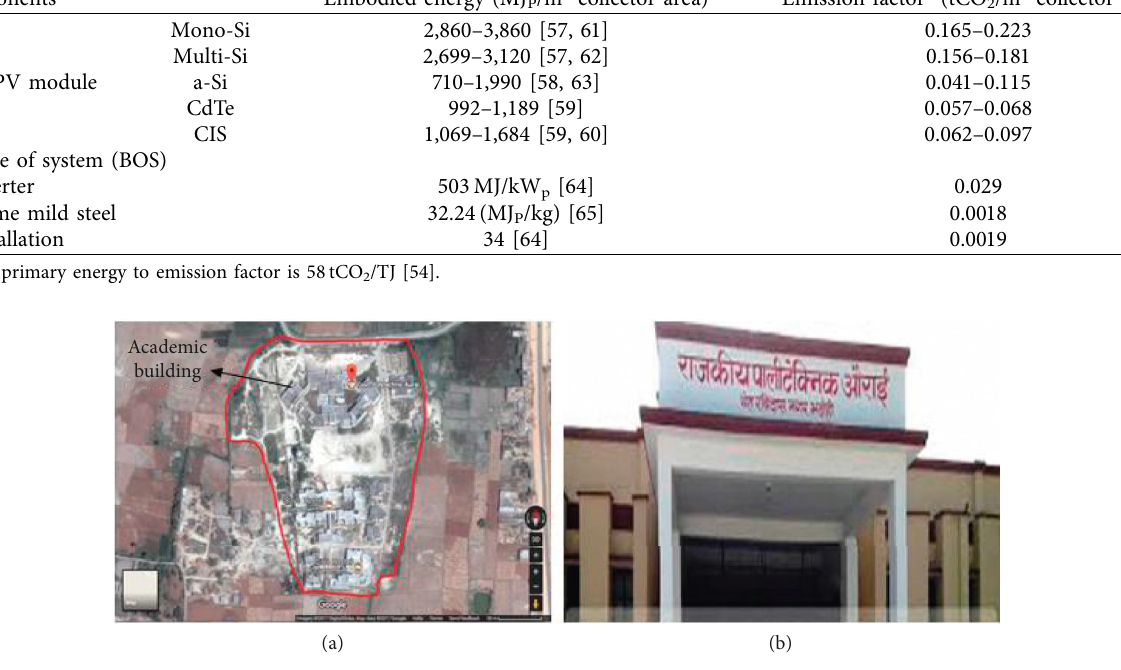
Figure 3: (a) Campus boundary (satellite view) and (b) image of the case building. Table 7: Details of the case study